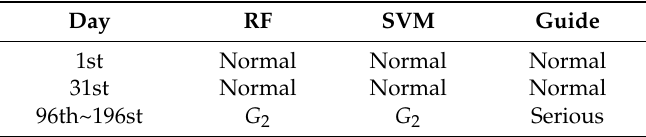
Table 8. The fault diagnosis results of three